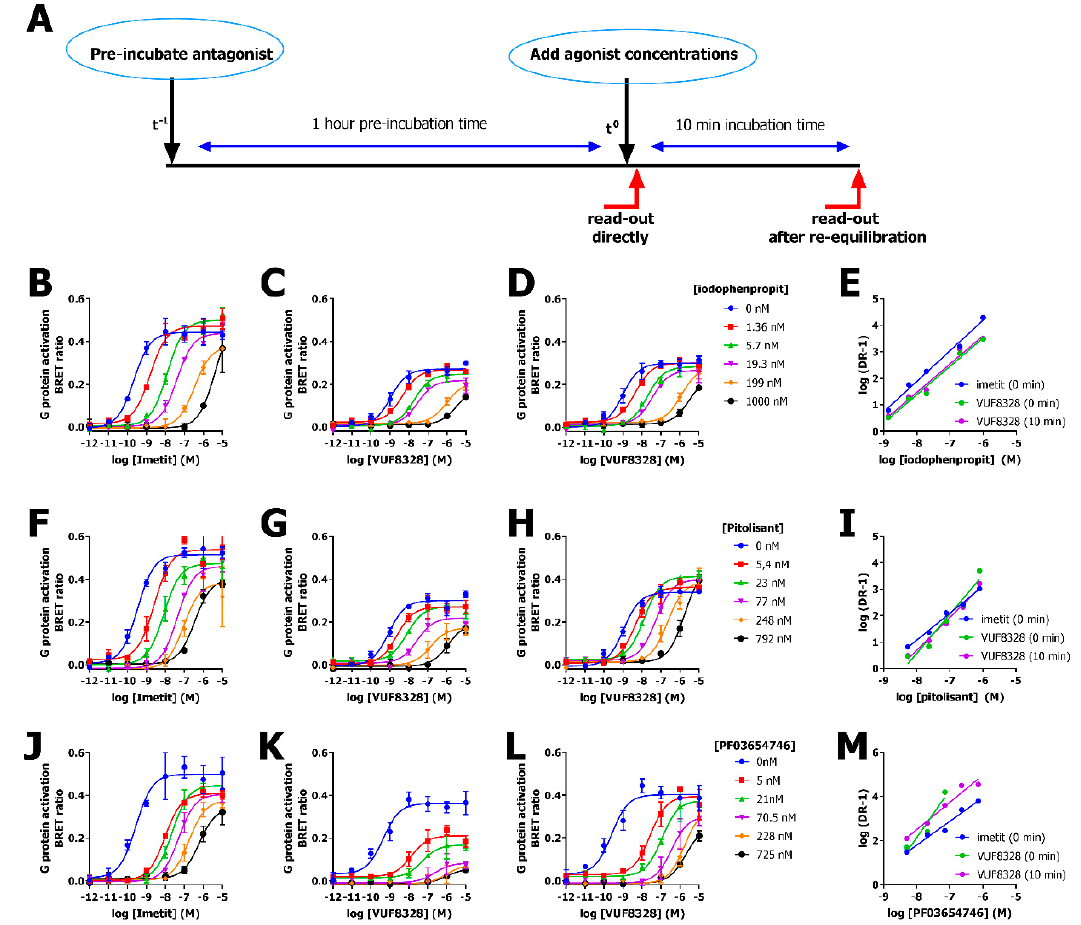
Figure 3. Concentration response curves of imetit in the presence of increasing concentrations of antagonists iodophenpropit ( B – D ), pitolisant ( F – H ) or PF03654746 ( J – L ) measured as BRET ratio between Venus-G β 1 γ 2 and masGRK3ct-Nluc in HEK293T cells co-expressing hH 3 R and G α i2 . ( A ) Cells were pre-incubated with antagonists for 1 h prior to stimulation with imetit ( B , F , J ) or VUF8328 ( C , D , G , H , K , L ) and BRET ratios were measured immediately ( B , C , F , G , J , K ) or 10 min ( D , H , L ) after agonist stimulation. Schild-plots for iodophenpropit ( E ), pitolisant ( I ), and PF03654746 ( M ) contain three regression-lines for the three different DRC panels. Representative graphs of 3 experiments performed in duplicate are shown and data are mean ± SD.